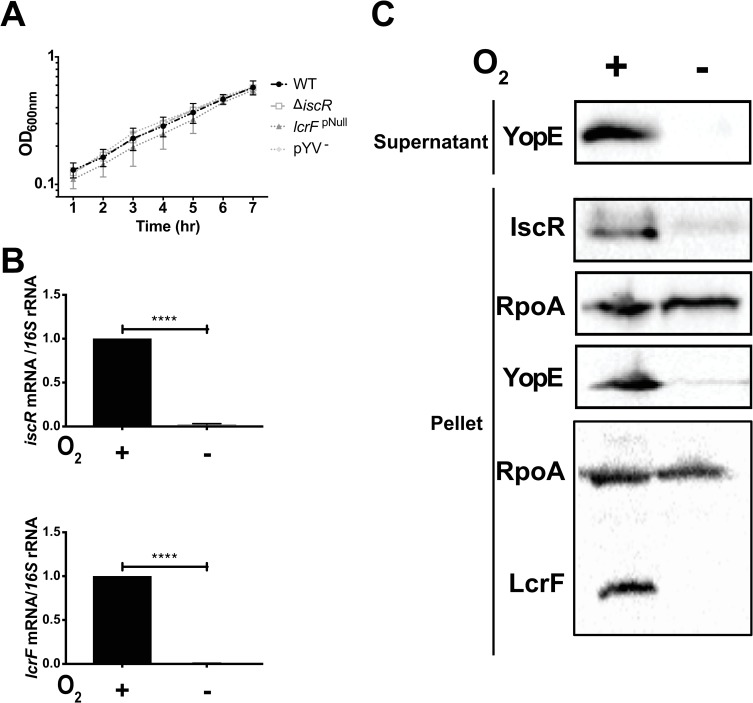
The Yersinia Ysc type III secretion system is induced by oxygen.(A)
Y. pseudotuberculosis was grown under anaerobic, iron-replete conditions at 26°C and optical density at 600 nm (OD600nm) measured every hour. Y. pseudotuberculosis pYV- lacks the pYV virulence plasmid and serves as a T3SS-deficient control strain. Data shown represent an average of three biological replicates. (B-C)
Y. pseudotuberculosis WT was grown in M9/high glucose (iron-replete) in the presence or absence of oxygen and type III secretion induced by shifting to 37°C for 4 hrs. (B) RNA was extracted from the bacterial cultures and iscR and lcrF gene expression analyzed using qPCR. Relative mRNA levels for each gene of interest were normalized to 16S rRNA levels. Data shown represent the average of three independent experiments. **** p ≤ 0.0001, as determined by unpaired t-test. (C) Equal amounts of cell lysates were probed with antibodies for RpoA, IscR, YopE, and LcrF. T3SS cargo proteins secreted into culture supernatant and precipitated with TCA were probed with YopE antibody. All samples shown are from the same experiment, with each lysate split into two gels, one subsequently used for IscR and YopE probing and the other for LcrF probing. RpoA was blotted on each membrane as a loading control. One representative experiment out of three is shown.